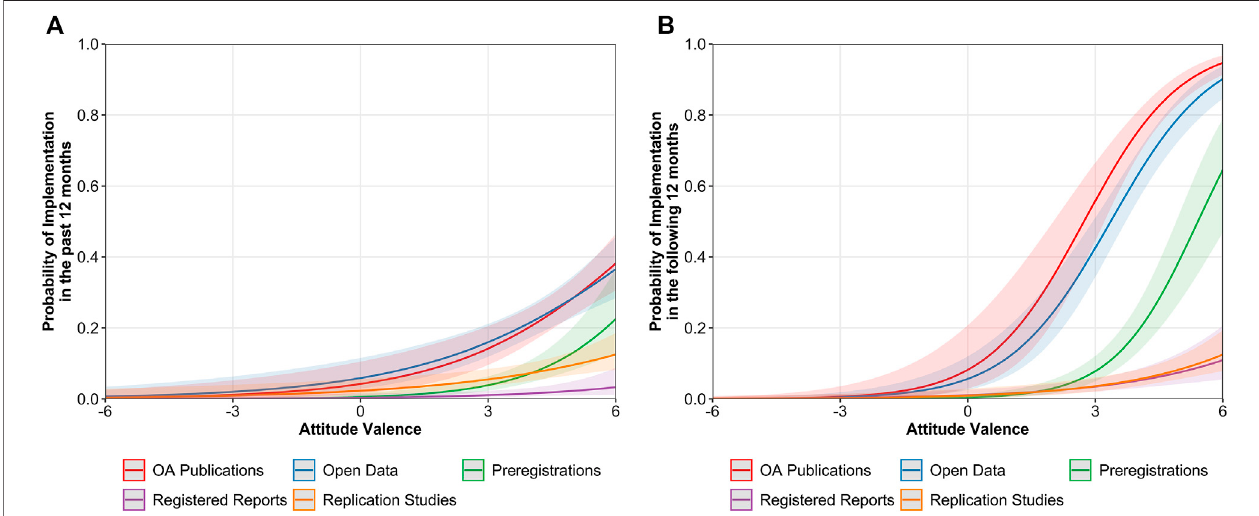
FIGURE 9 | Predicted values of implementation in the past 12 months (A) and in the following 12 months (B) as a function of ECRs ’ attitude valence across OS practices. Bandwidths represent 95% con fi dence intervals (CIs).